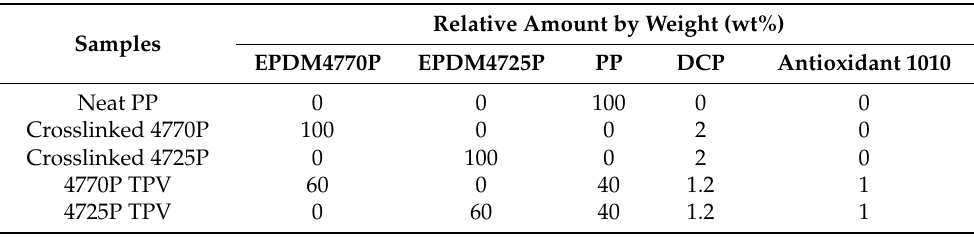
Table 2. The 2 wt% of DCP was selected to crosslink with EPDM. Table 2. The composition proportion of neat PP, crosslinked EPDMs, and EPDM/PP thermoplastic